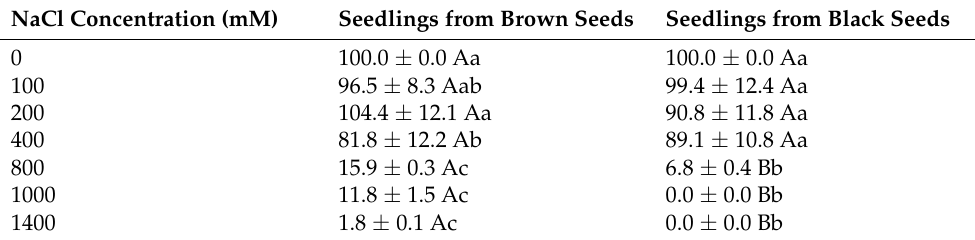
Table 3. Radicle tolerance index of seedlings from dimorphic seeds under different NaCl concentrations. NaCl Concentration (mM)